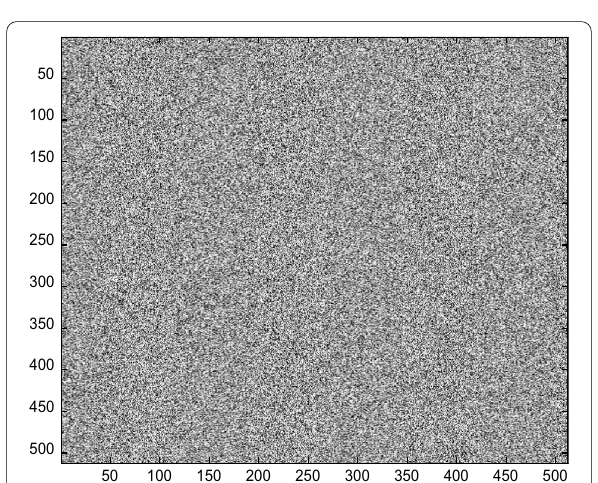
Fig. 3 A diffuser d ( u , v ) in the form of randomly distributed function of dimensions 512 512 ×